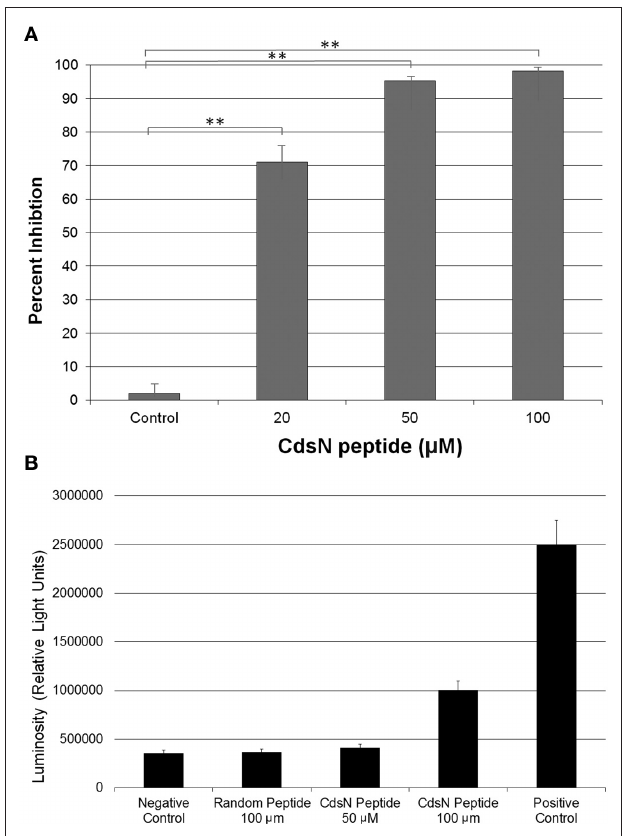
FIgure 6 | CdsN peptide containing the CdsL binding sequence TrFArA inhibits the infection of HeLa cells in a dose-dependent fashion and shows low toxicity at 50 μM. Shell vials grown to 85% confluency were infected with Chlamydia pneumoniae at an MOI of 3 after incubation with the CdsN or control peptide. Infected cells were counted by staining with a Chlamydia specific major outer membrane protein (MOMP)-monoclonal antibody (Pathfinder kit). Toxicity was measured using an adenylate kinase release assay for HeLa cells in the presence of either the CdsN or control peptide. (A) CdsN peptide was added at increasing concentrations (20, 50, and 100 μM) and demonstrated a dose– response in reduction of C. pneumoniae infectivity of HeLa cells. The control represents a random peptide with the sequence MFAVNAQ–MTS that had no effect on C. pneumoniae infectivity. All experiments were performed in triplicate and data is presented as the mean with error bars representing the mean + 1 SD with **representing p < 0.01. (B) Toxicity of the CdsN peptides toward HeLa cells was evaluated using the Lonza adenylate kinase release assay. The CdsN peptide was added to HeLa cells for 1 h at 50 and 100 μM, and the random peptide was added for 1 h at 100 μM. We saw that the CdsN peptide at 50 μM had no toxicity toward HeLa cells, and only minor toxicity at 100 μM.